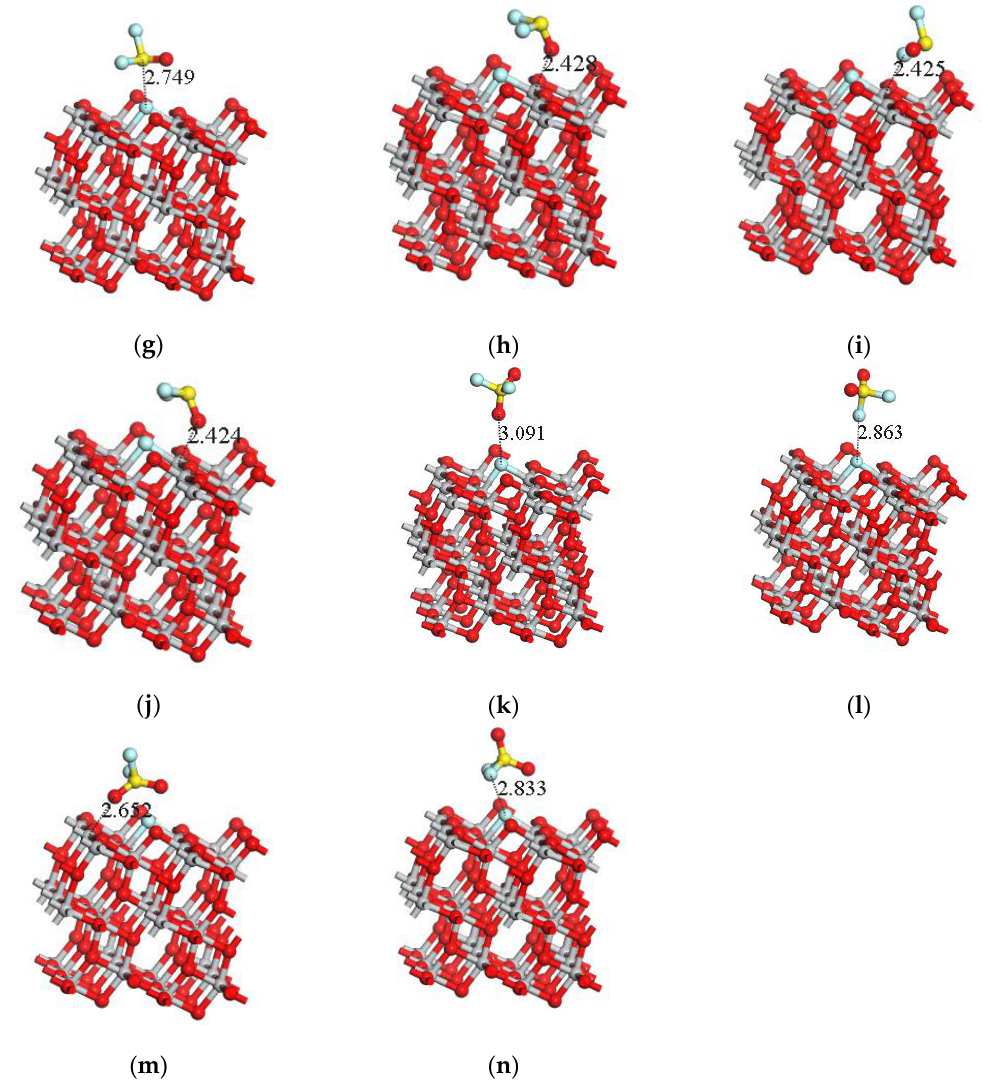
Figure 4. The adsorption structures of four gas molecules adsorbed on the crystal surface in different ways. ( a – n ) are the adsorption structure of four gas molecules adsorbed on the F-doped TiO 2 crystal plane in different ways after complete optimization calculation.